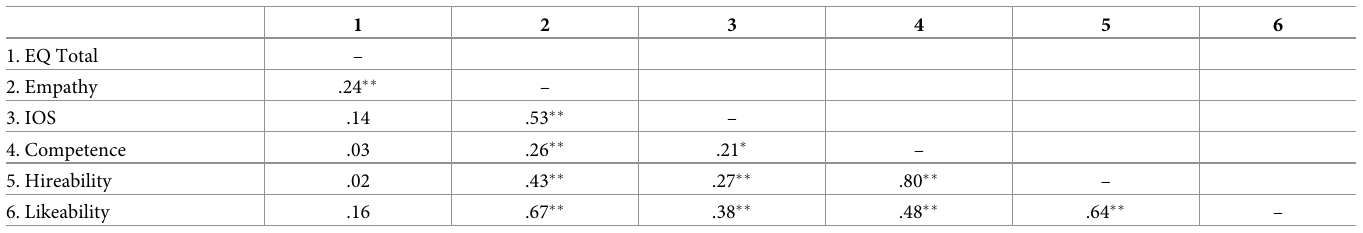
Table 12. Zero order correlations–male